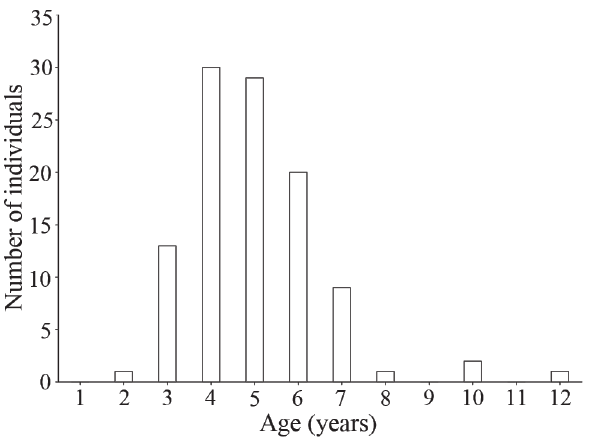
Fig. 3. Age absolute frequency for the dusky grouper ( Mycteroperca marginata ) collected in the study area. n =